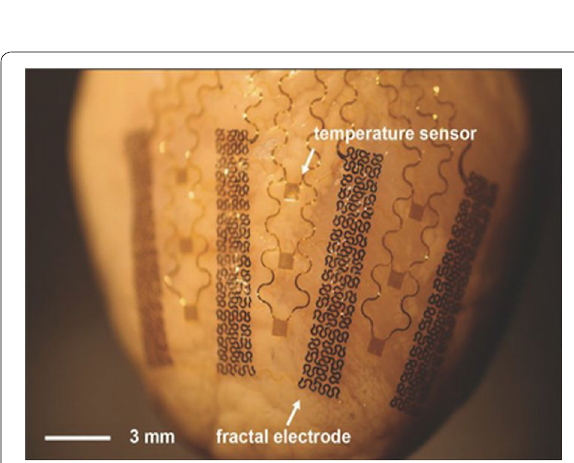
Fig. 4 An image attached to the outer wall of the rabbit heart with an elastic membrane containing a multifunctional sensor capable of providing electrical stimulation (the white arrows indicate the electrodes of the sensor and the fractal structure) (Reproduced with permission from Ref. [37], © 2015 WILEY VCH Verlag GmbH &